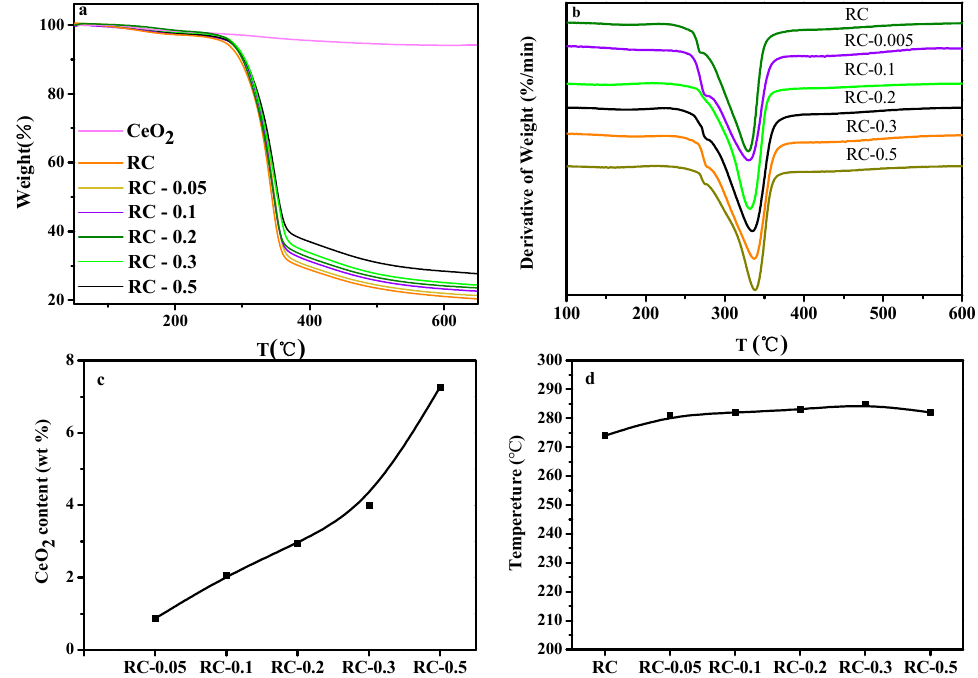
Figure 8. TGA ( a ) and DTG ( b ) curves for RC and RC/CeO 2 nanocomposite films under nitrogen atmosphere; ( c ) the influences of Ce(NO 3 ) 3 ·6H 2 O concentrations on the content of the incorporated CeO 2 NPs (wt%) in the nanocomposite films; ( d ) the temperature at 5 wt% decomposition of RC and RC/CeO 2 nanocomposite films.